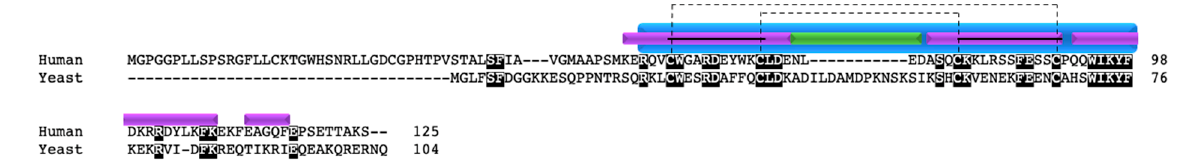
Figure 8. COA6. Alignment of human and yeast COA6 protein sequences. Purple boxes indicate a helix. Black boxes indicate conserved residues. Human sequence annotation is as follows: Blue box indicates the CHCH domain. Purple boxes indicate a helix. Green boxes indicate a turn. Solid black lines indicate the CX 9 C-CX 10 C motif. Dashed lines indicate the cysteine pairs that form structural disulfide bonds.